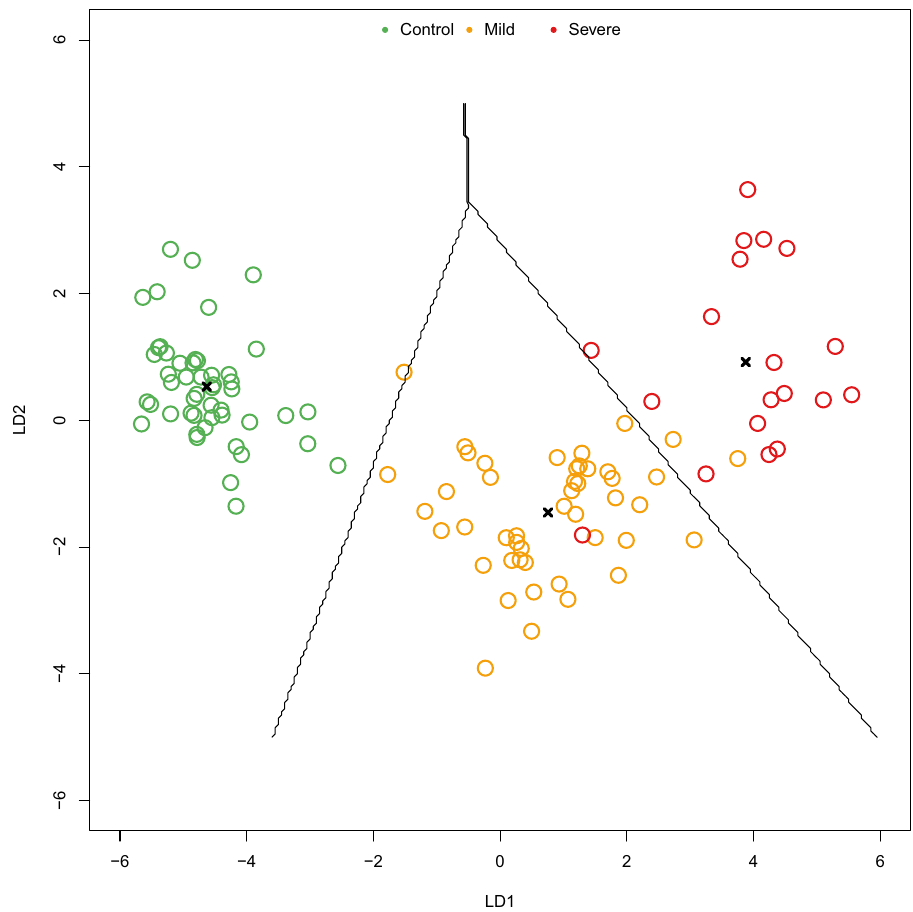
Figure 3. 27 cytokine-based algorithm allows to predict disease state and severity. 2D scatterplot of each subject’s cytokines. LDA projection is based on two-component LD1 and LD2 whose coefficients are reported in Supplementary Table